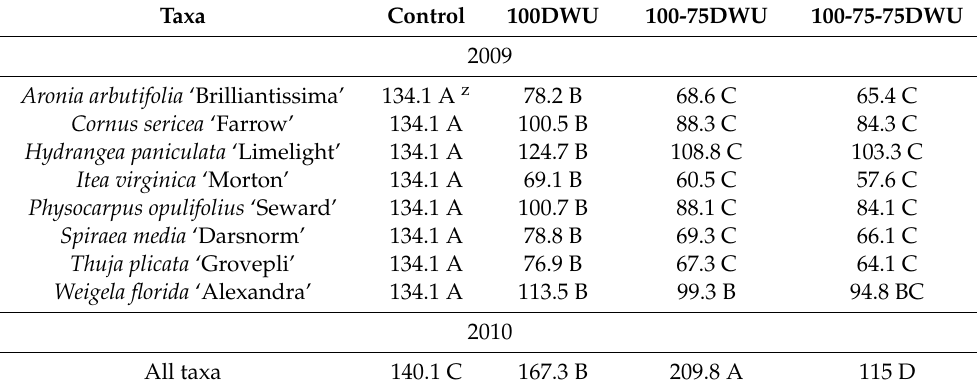
Table 1. Total irrigation application (L . container − 1 ) to 4 irrigation treatments from 11 June (Day 1) to 14 October 2009 (Day 126) and 23 June (Day 1) to 31 October 2010 (Day 131). Control = 19 mm . application − 1 (1.07 L . container − 1. day − 1 ); 100DWU = 100% daily water use (DWU) replacement each day; 100-75DWU = 2 day cycle alternating 100% DWU and 75% DWU; and 100-75-75DWU = 3 day